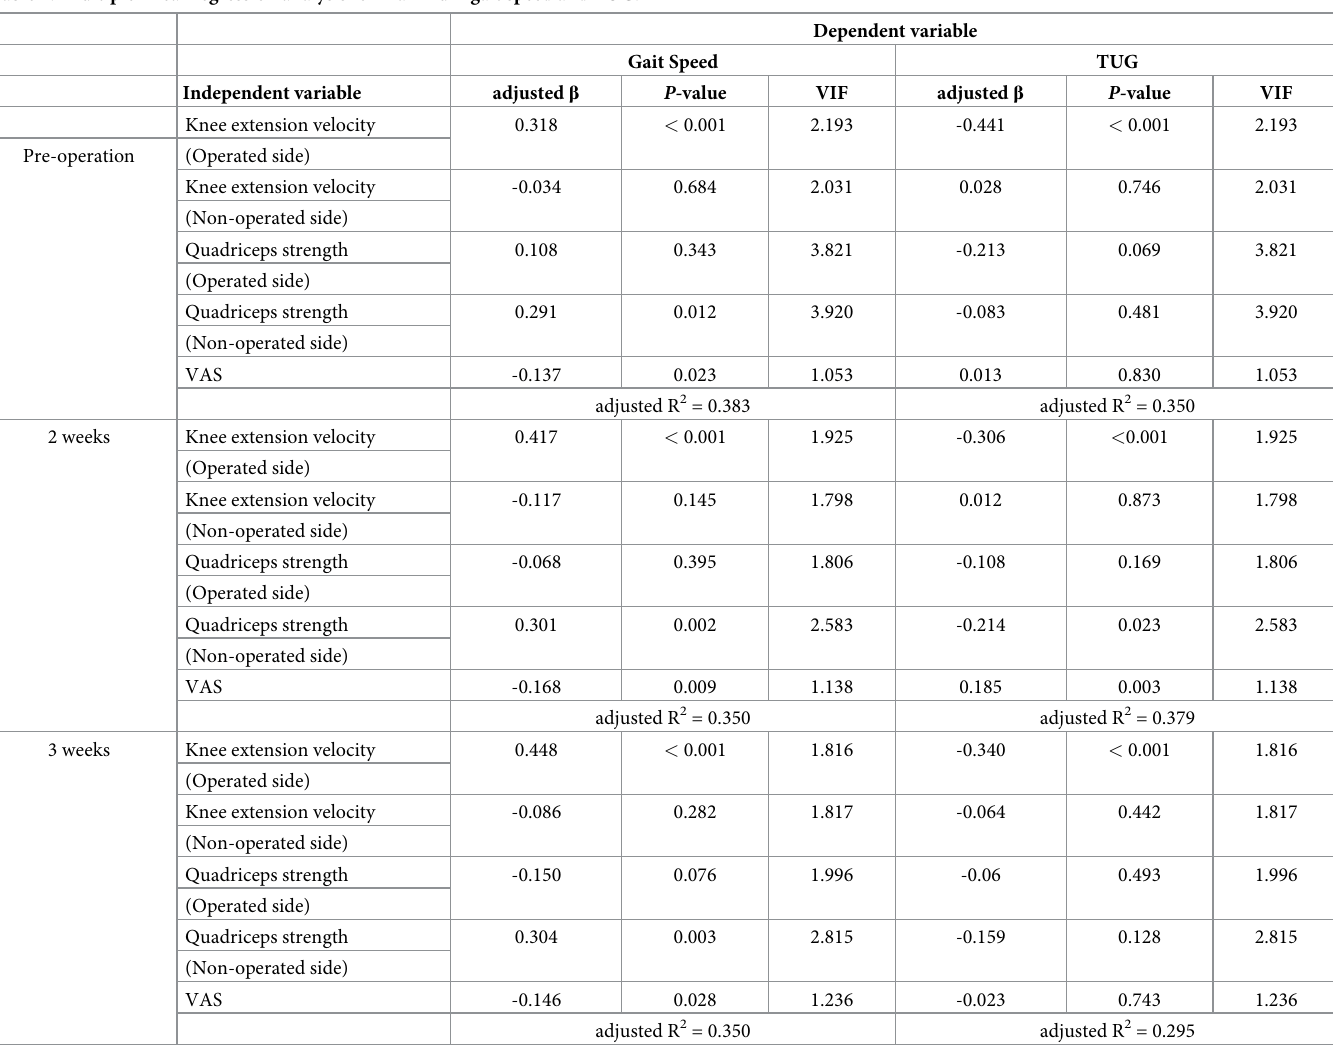
Table 4. Multiple linear regression analysis for maximum gait speed and